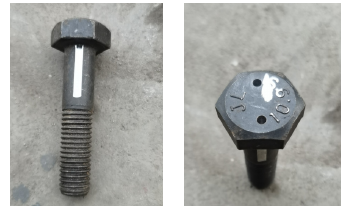
Figure 3. Strain measuring point position.